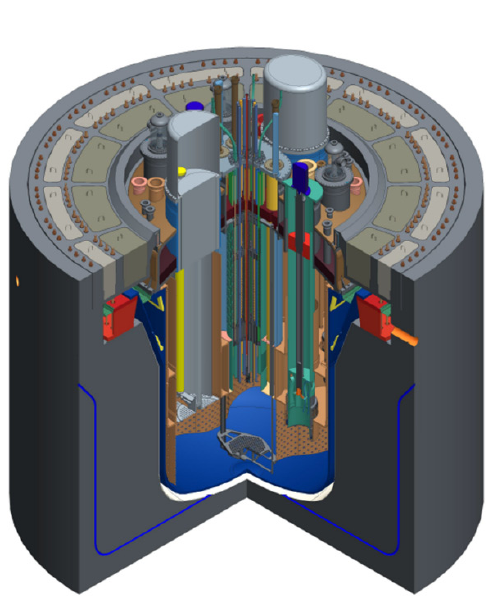
Fig. 5. – 3-D Schematic view of the MYRRHA sub-critical reactor.